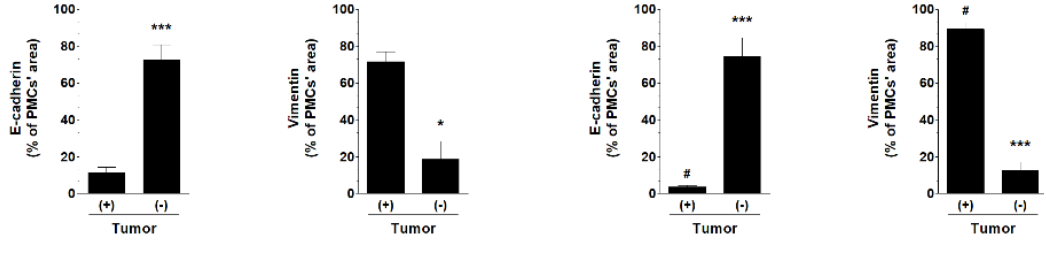
Figure 2. Features of MMT in human PMCs in vivo. ( a ) Expression of E-cadherin and vimentin in tumors from patients with high-grade serous ovarian cancer cells (HGSOCs) or endometrioid ovarian cancer, as well as in the cancer-free areas of the omentum from the same patients. The very left panel of pictures shows the identification of PMCs according to the expression of D2-40 antigen (brown reaction). Arrows indicate a layer of PMCs with different magnitudes of positive (brown) staining. Ca—cancer cells; Scale bars = 50 µm. ( b ) Quantification of the E-cadherin and vimentin levels in the biopsies using ImageJ software. Experiments were performed with tumors obtained from eight patients per group. The results are expressed as the mean ± SEM. ***, p < 0.001 vs. tumor (+); # , p < 0.05 vs. endometrioid tumors.